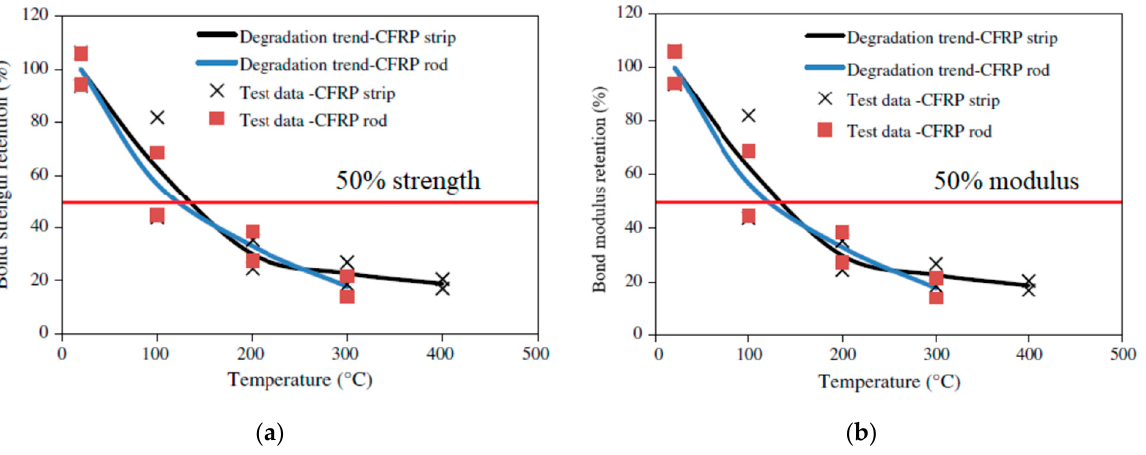
Figure 15. Variation of bond strength and elastic modulus of NSM CFRP strip and rod with Tyfo S epoxy with temperature; ( a ) Bond strength; ( b ) Bond modulus.